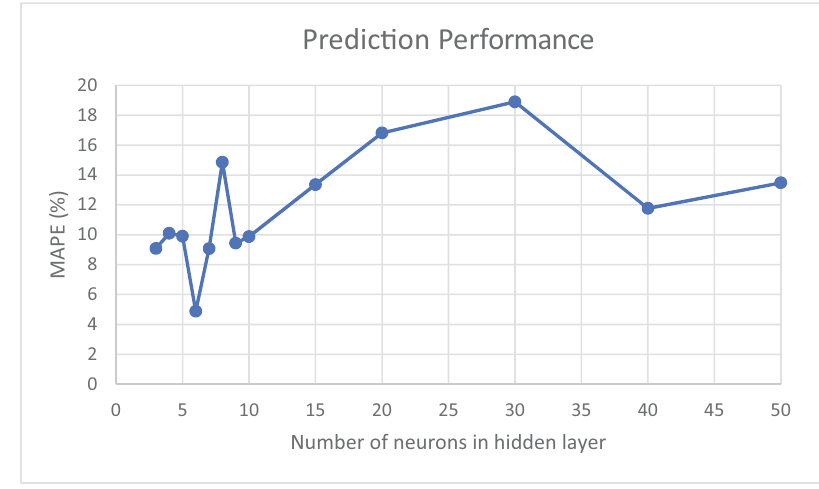
Figure 4: MAPE values of the developed ANN